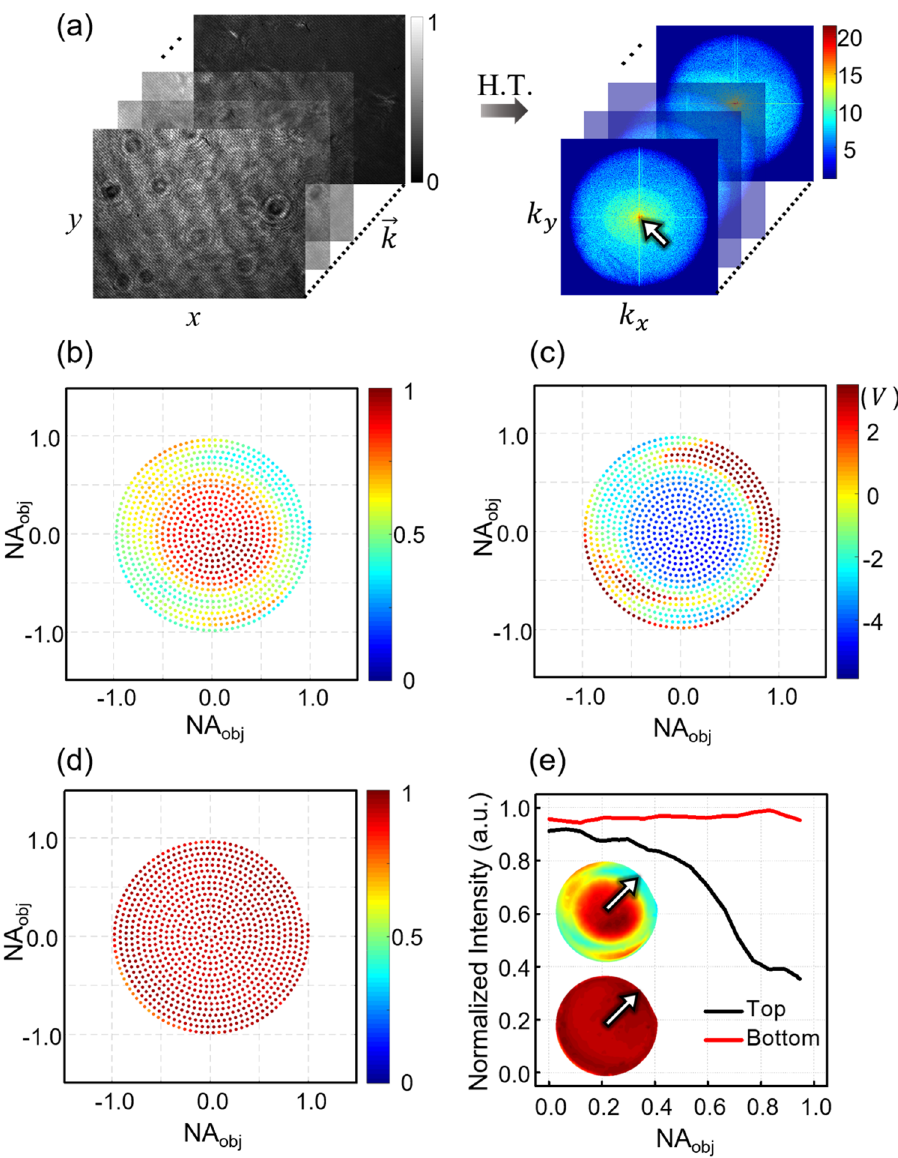
Figure 3. Uniformity of the interference contrast. ( a ) Raw interferograms at various illumination angles and corresponding angular spectra in k -space. The center peak in the k-space is indicated by a white arrow. ( b ) (cid:31) k ) Normalized η( mapped in the NA of the objective lens without the AM control. ( c ) Driving voltage required (cid:31) k ) for the AM control. ( d ) Normalized η( with the AM control. ( e ) Section profiles along the direction along the white arrows in insets. Insets: interpolated images of ( b ) top and ( d )